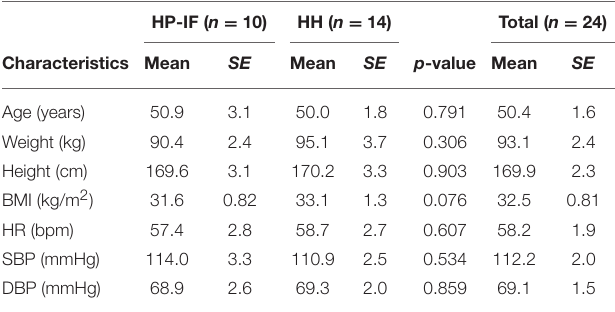
TABLE 6 | Baseline (week 12) characteristics of participants for WL-M (Phase 2).